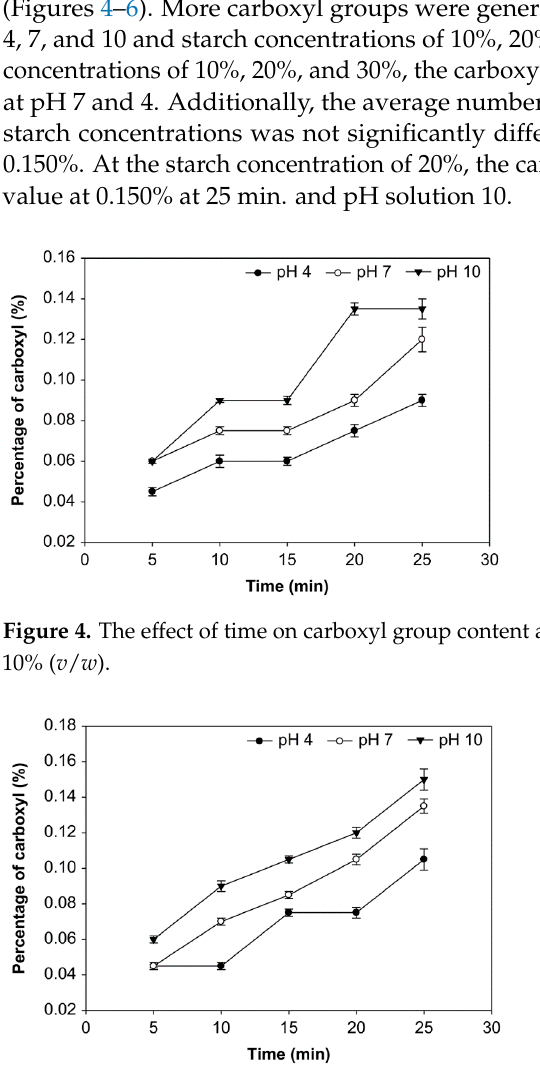
Figure 5. The effect of time on carboxyl group content at various pH with the starch concentration of 20% ( v / w ).